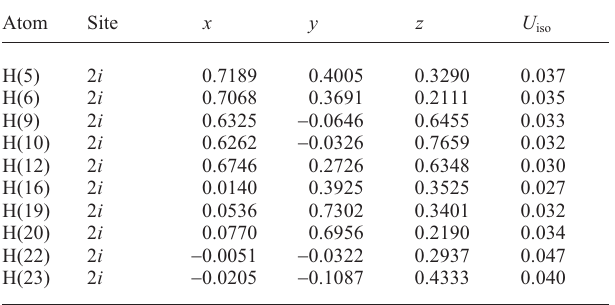
Table 3. Atomic coordinates and displacement parameters (in Å 2 )